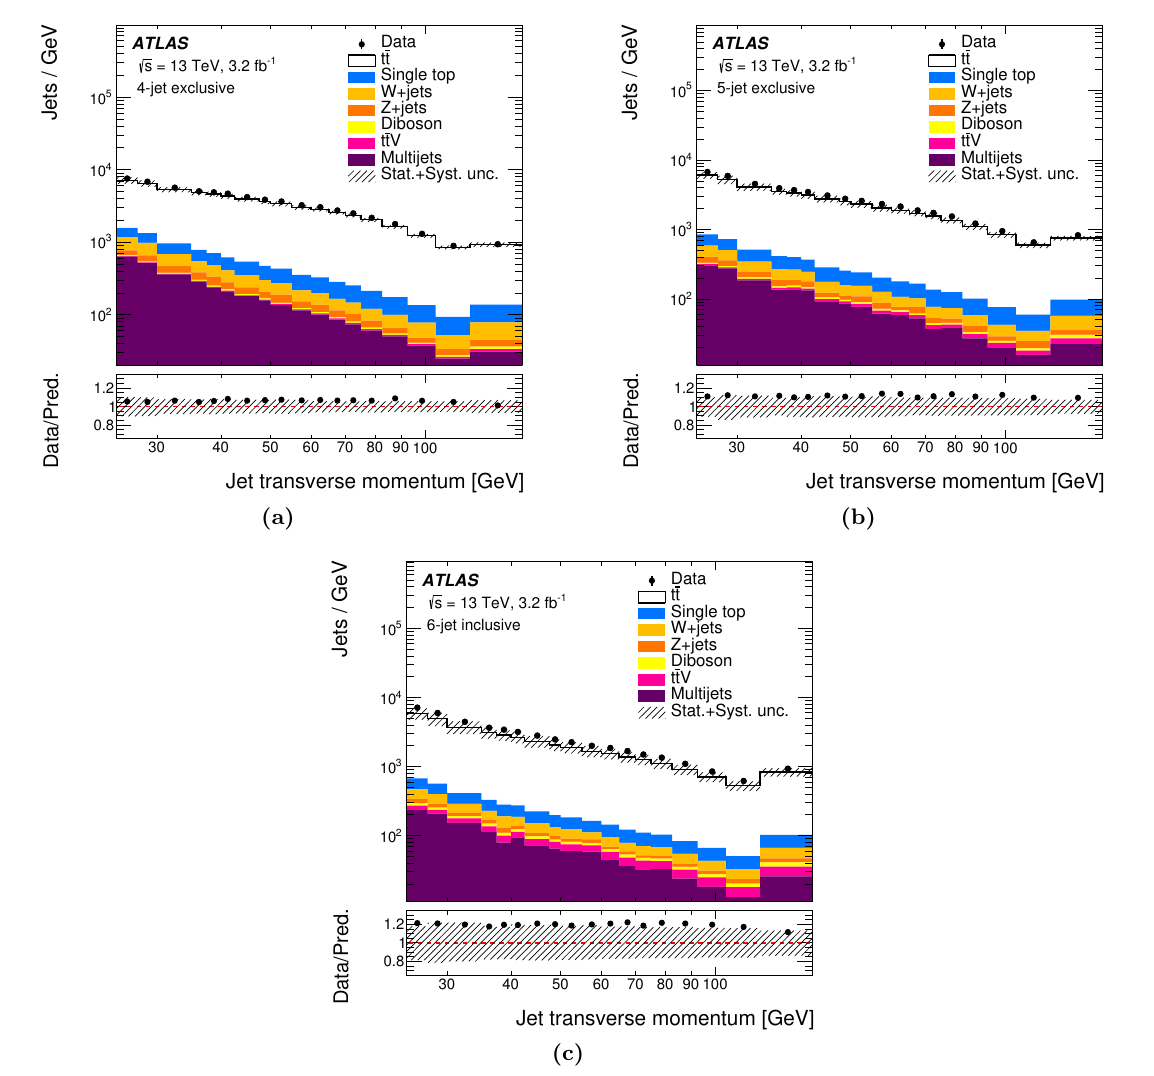
Figure 2 . Distribution of the transverse momentum of selected jets in the (a) 4-jet exclusive, (b) 5- jet exclusive and (c) 6-jet inclusive con(cid:12)gurations at reconstruction level. Data are compared to the sum of signal and background predictions using the nominal sample as the t (cid:22) t signal model. The hatched area indicates the combined statistical and systematic uncertainties in the total prediction, excluding systematic uncertainties related to the modelling of the t (cid:22) t production. Events beyond the range of the horizontal axis are included in the last